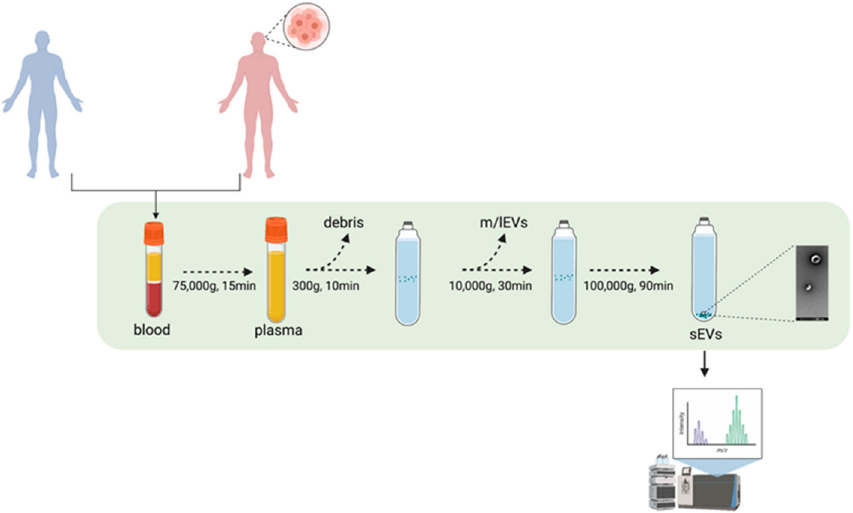
Figure 1. Experimental pipeline. sEVs from GB patients and healthy volunteers’ blood samples were isolated through UC. The proteomic content of the sEVs were deciphered using mass spectrometry. Figure was created using BioRender.com.